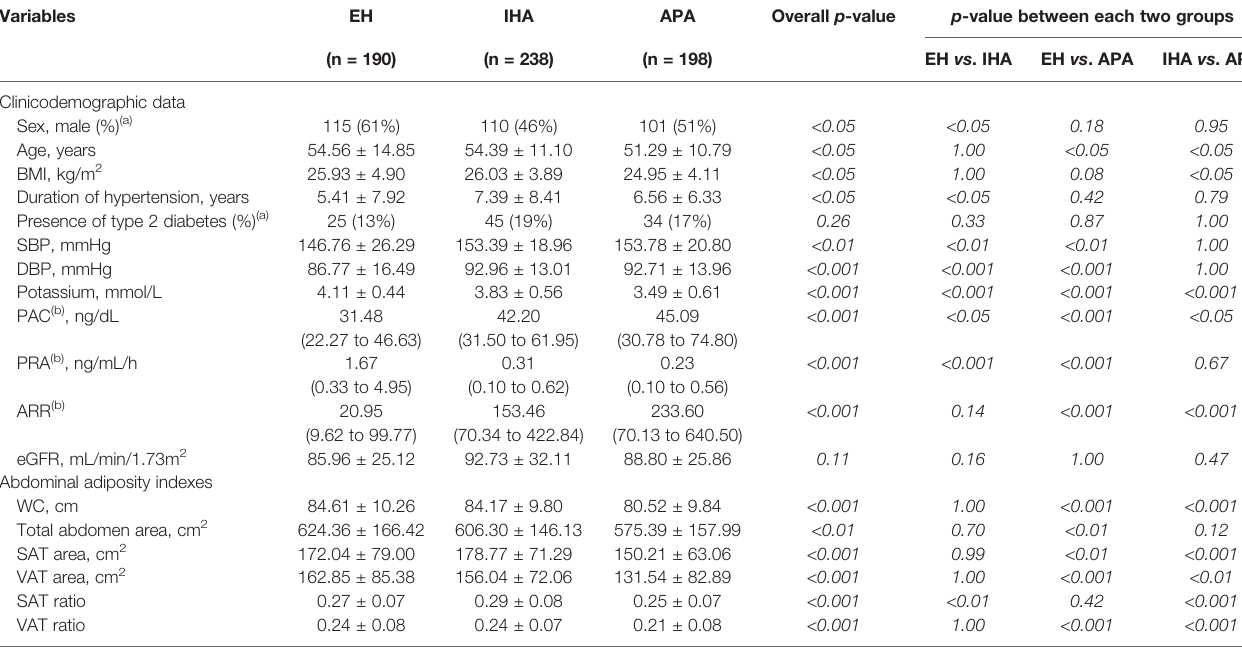
TABLE 1 | Comparison of clinicodemographic data and abdominal adiposity indexes among the EH, IHA, and APA groups.